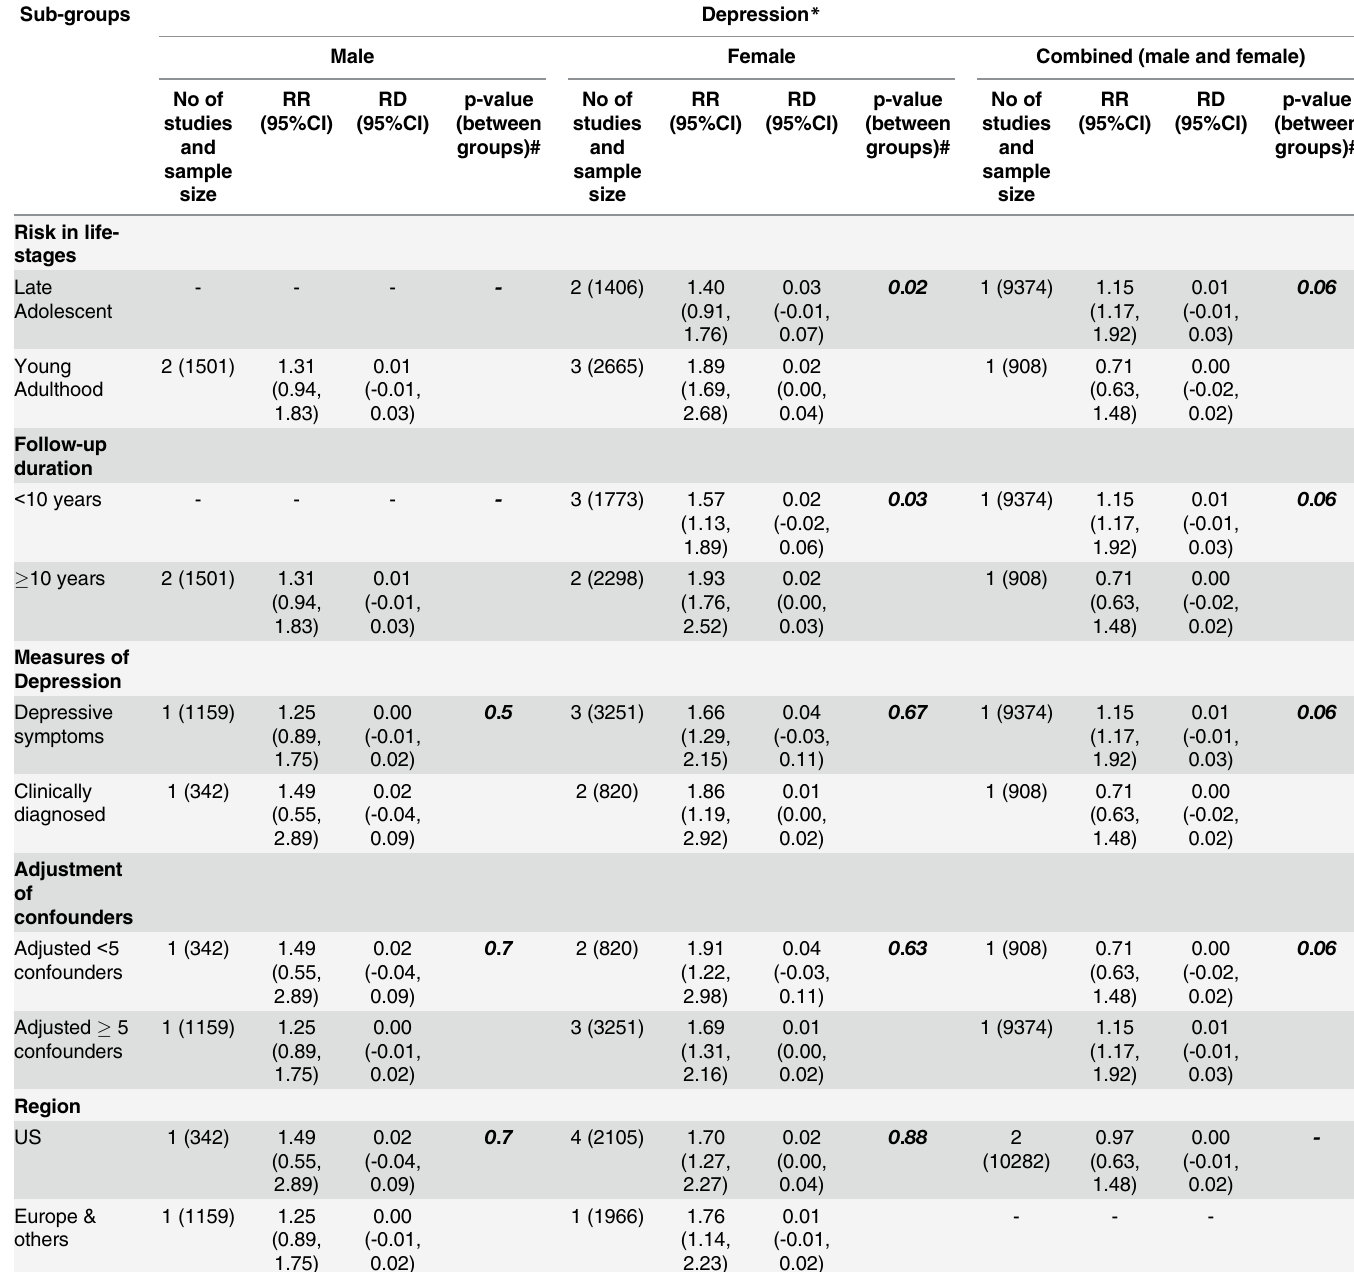
Table 5. Sensitivity analyses of obesity leading to